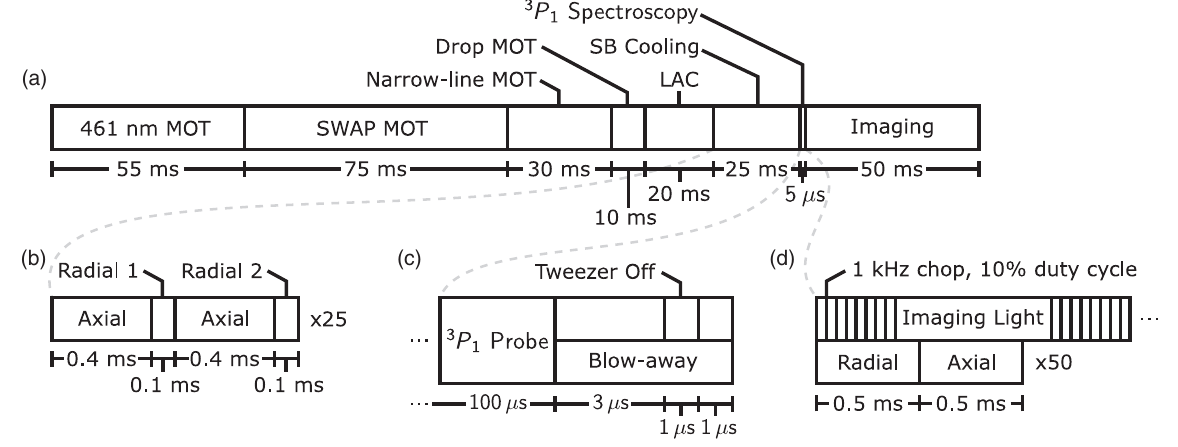
FIG. 6. Characteristic timing diagram. (a) Full experimental sequence for taking 3 P 1 spectra. (b) – (d) Detail views of sideband (SB) cooling, 3 P 1 transfer, and imaging sequences,